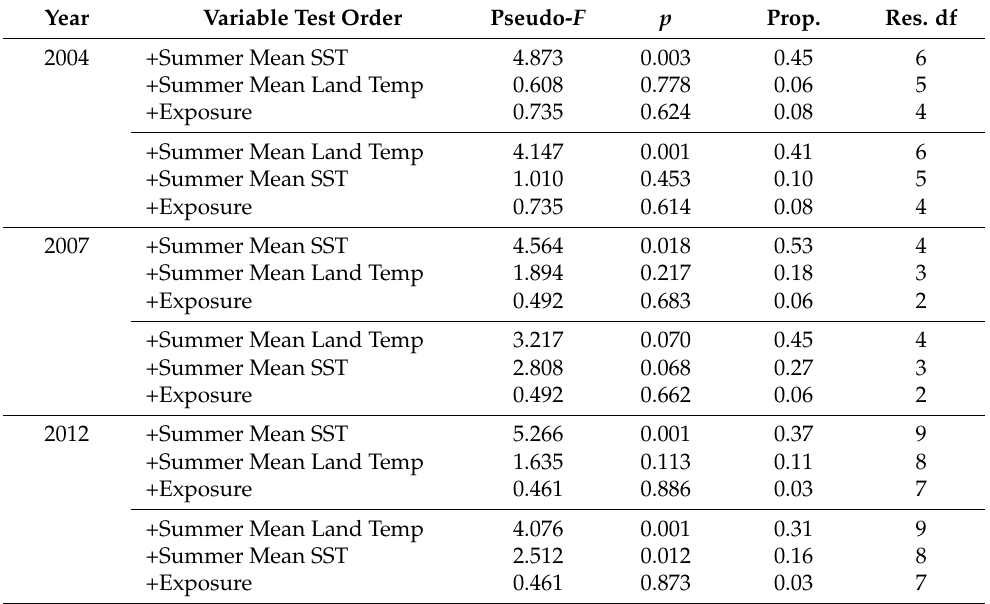
Table 7. Sequential conditional test results of distance-based linear modelling of species similarity with temperatures and exposure for survey years. Variables are fit to models as covariables and evaluated as sets. The sequence of SST and land temperature was switched in tests for each year. The proportion of variation (Prop.) of an added variable is its contribution to the amount already explained by the preceding variable (Res. df, residual degrees of